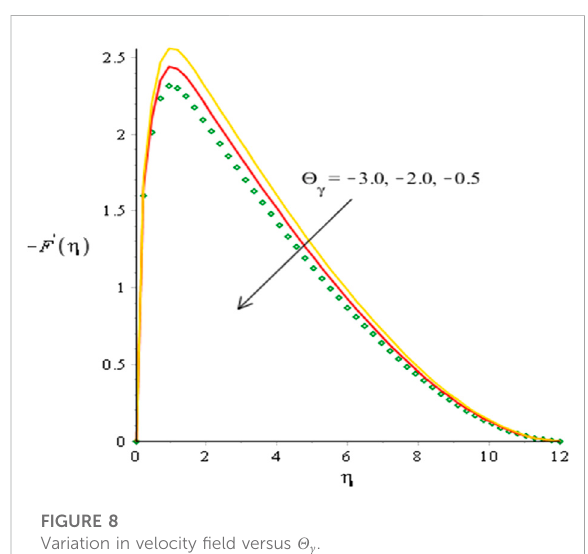
FIGURE 8 Variation in velocity fi eld versus Θ γ .